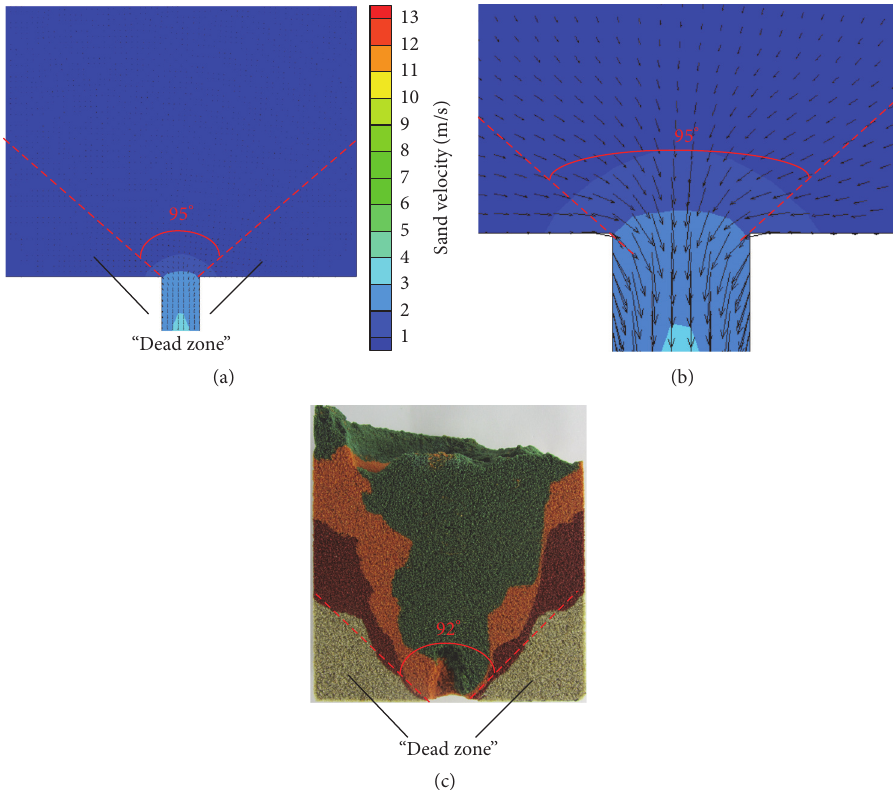
Figure 10: (a) Vector plots of sand velocity for 𝑡 = 330 ms with sand velocity distribution superimposed, (b) magnification of the entrance region in (a), and (c) the state of the colored core sand in the shooting head after core shooting process.